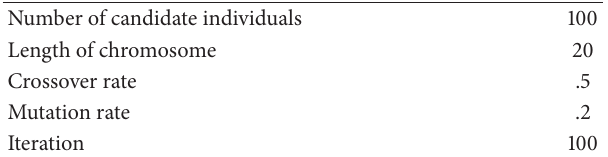
Table 6: GA parameter